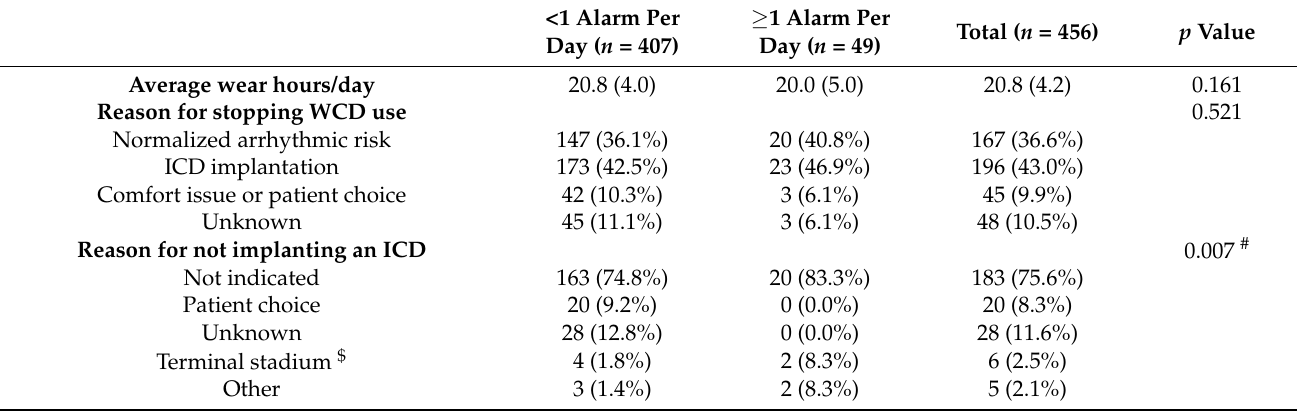
Table 3. Alarm burden in WCD